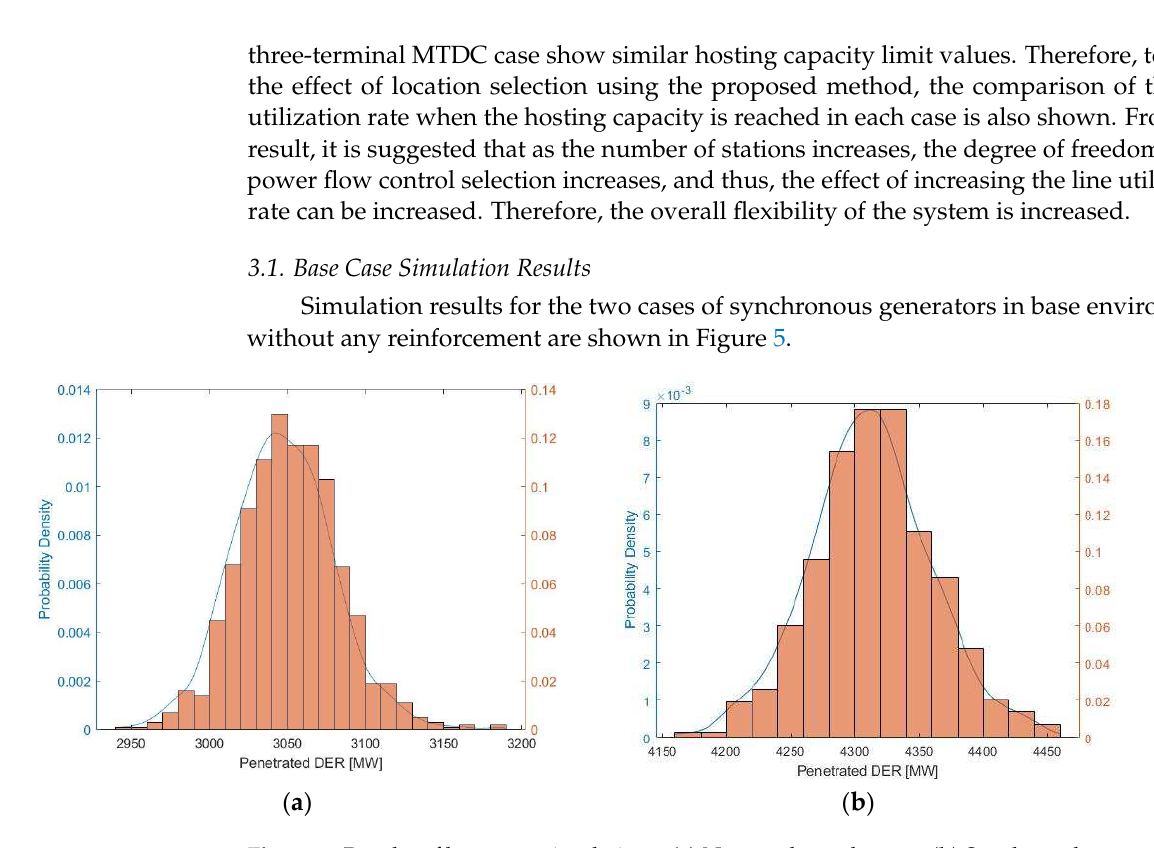
Figure 5. Results of base case simulations: ( a ) No − synch condensers; ( b ) Synch condensers.